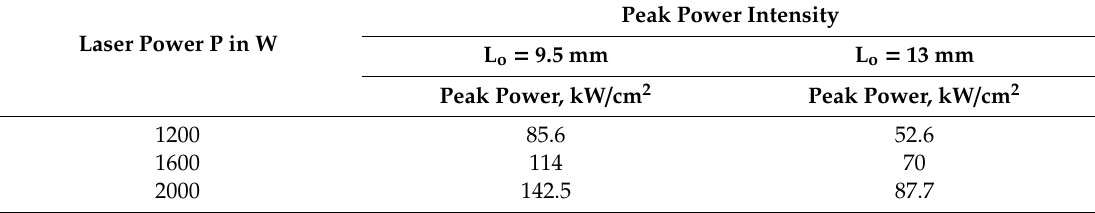
Figure 1. ( a ) Gaussian distribution of power intensity; ( b ) laser beam profile for P of 1200 W and L o of 9.5 mm above the focal point. 9.5 mm above the focal point. Table 3. Peak power intensity for di ff erent L o at varying Table 3. Peak power intensity for different L o at varying P.